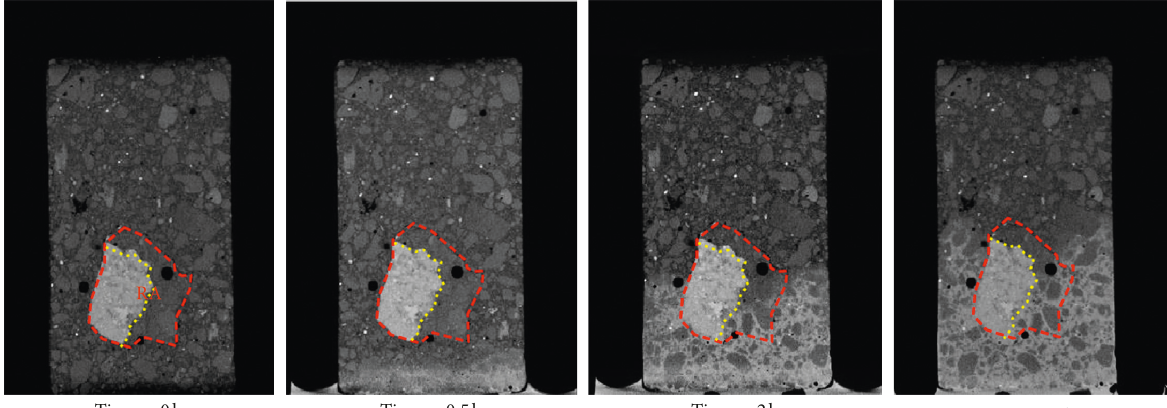
Figure 3: Chloride ion penetration paths in RAC with FA.